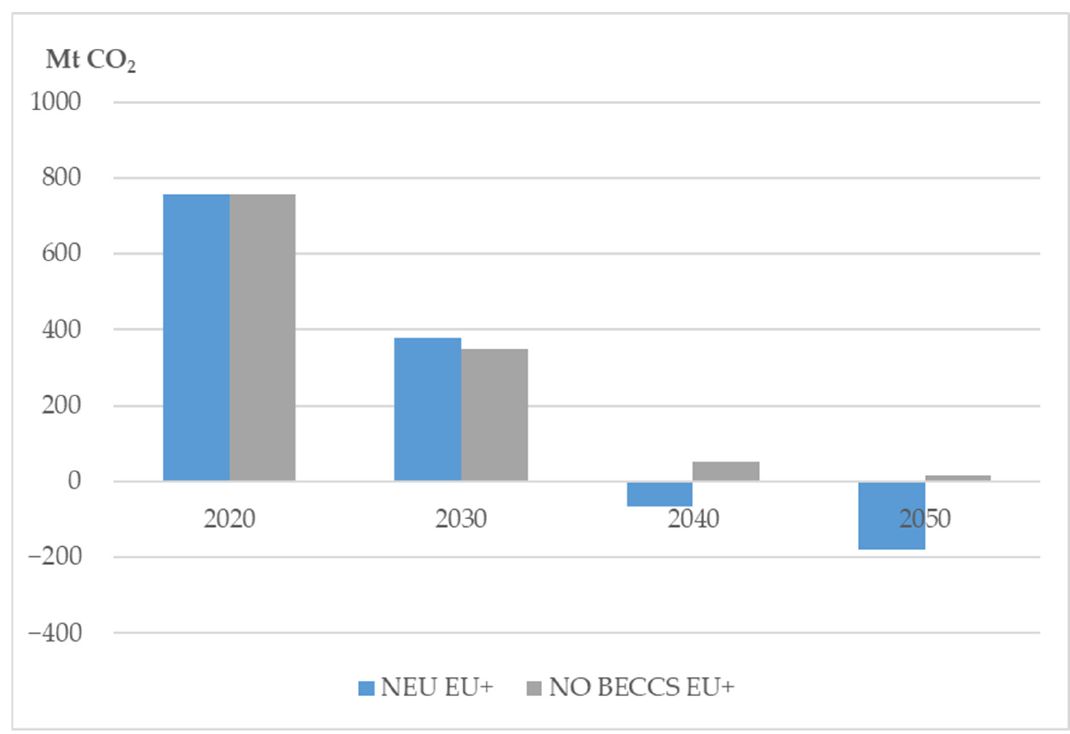
Figure 10. Total CO 2 emissions in the EU+ energy sector (in Mt CO 2 ). Source: own calculations based on MEESA